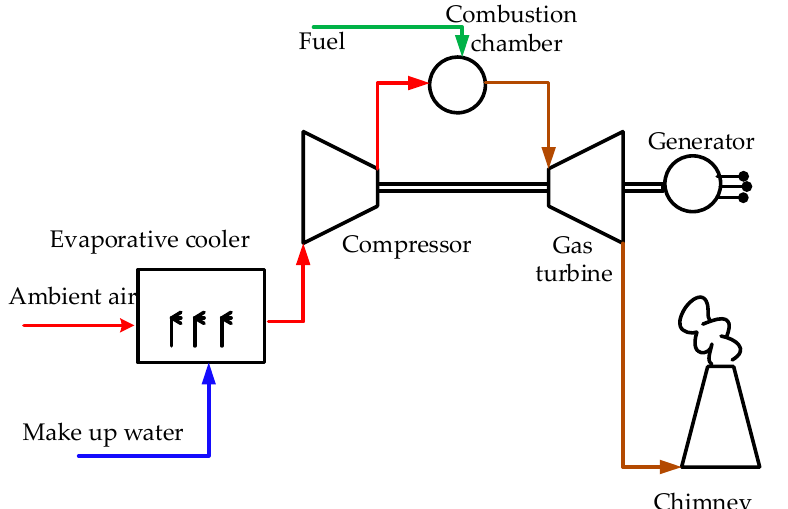
Figure 2. Gas turbine with evaporative inlet cooling.